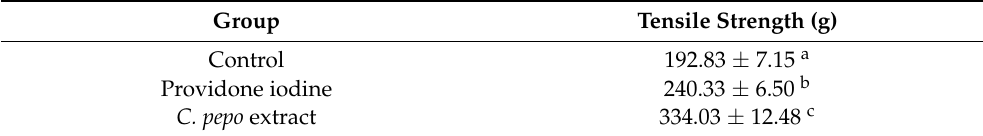
Table 6. Effect of applying Povidone iodine and C. pepo extract on tensile strength of rats’ incision wounds.